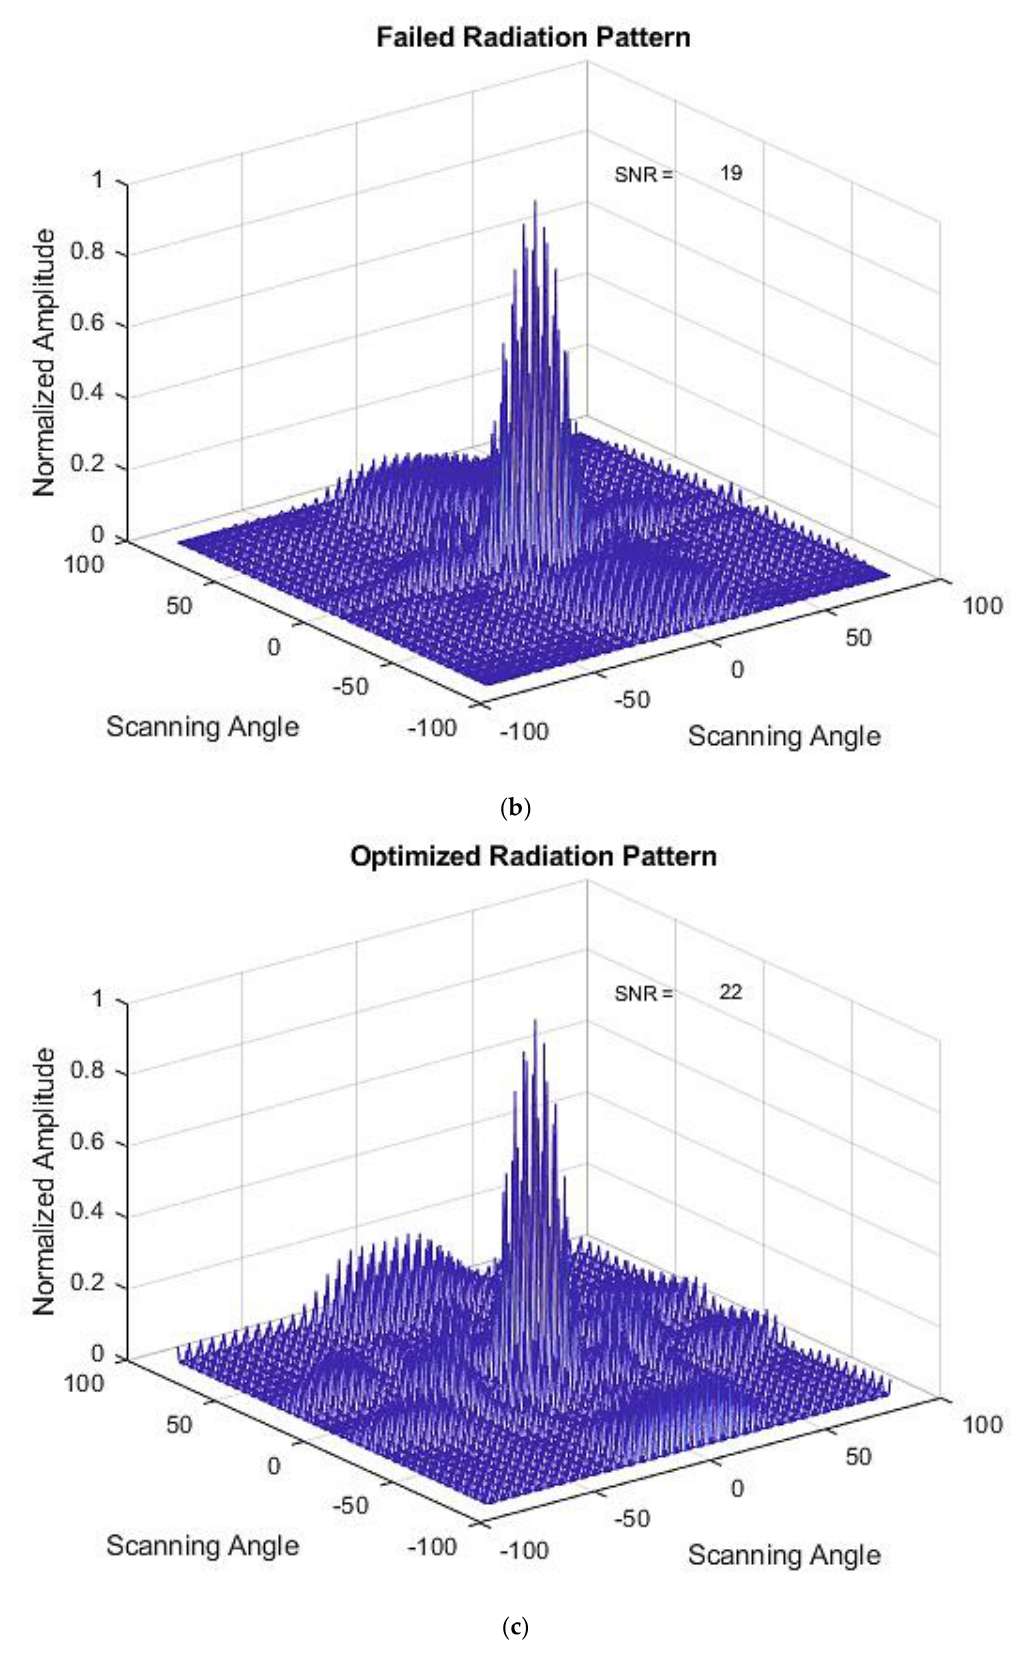
Figure 7. ( a ) Initial Radiation Pattern for the SA Method. ( b ) Failed Radiation Pattern for the SA Method. ( c ) Optimized Radiation Pattern for the SA Method.